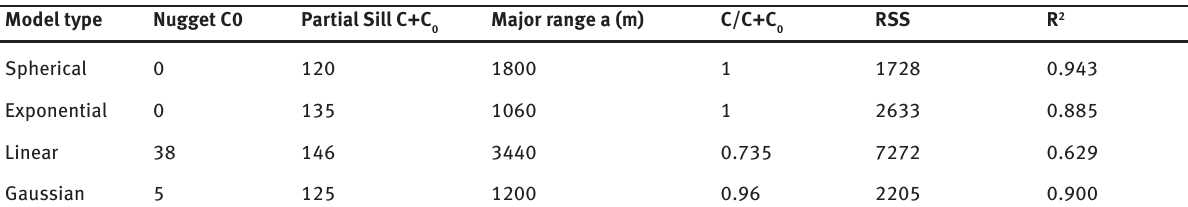
Table 4: Properties of the fitted semivariograms of the liquefaction potential index.